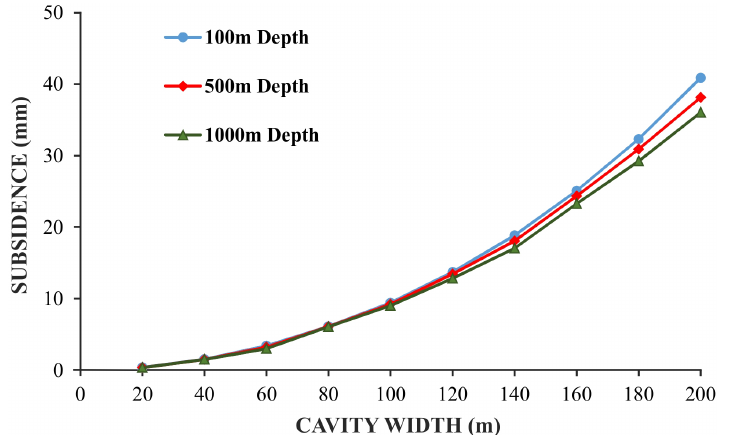
Figure 12. Effect of cavity width and depth on subsidence.